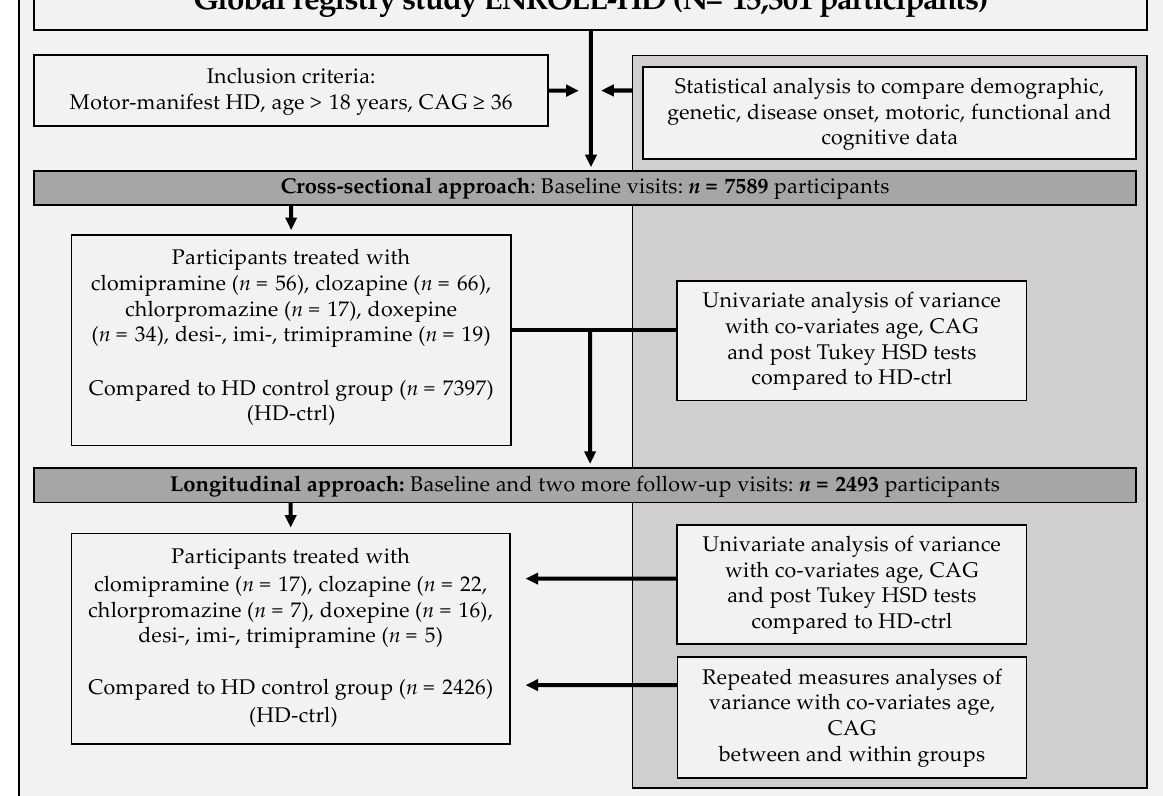
Figure 1. Schematic workflow of the study.